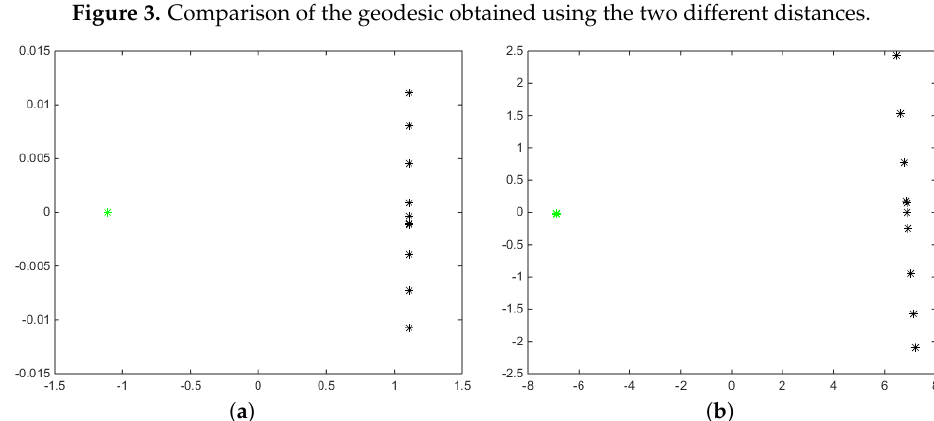
Figure 4. Multidimensional scaling (MDS) applied to the distance matrices: ( a ) using d new , ( b ) using d 2 . The ten spirals are marked in green and the ten circumferences are represented with black asterisks.